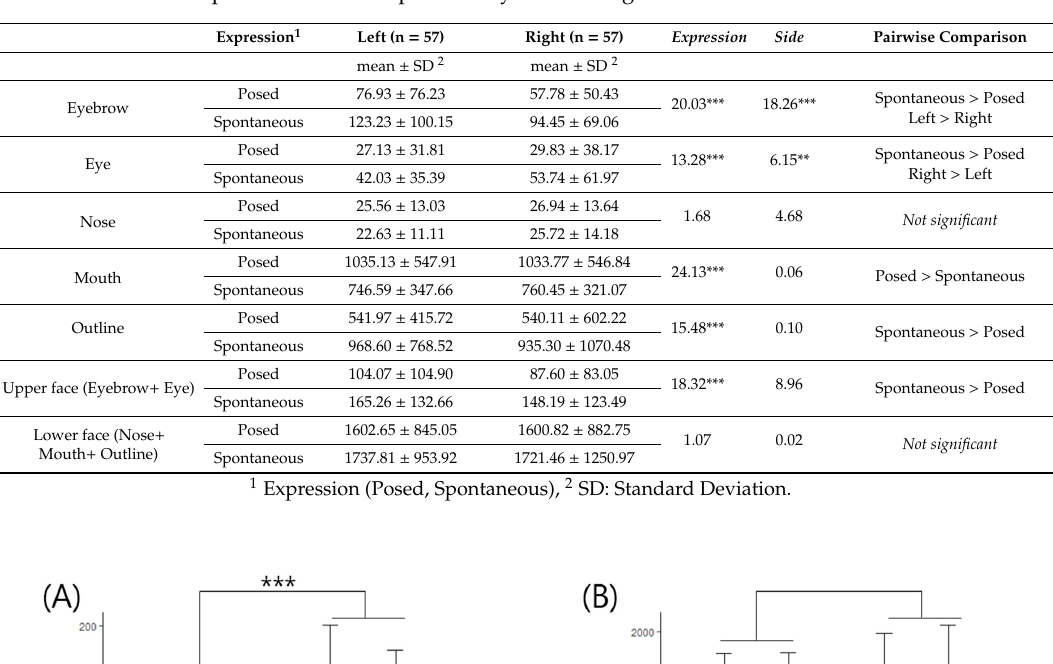
Table 4. Comparison of smile expression by left- and right face based on facial landmarks.